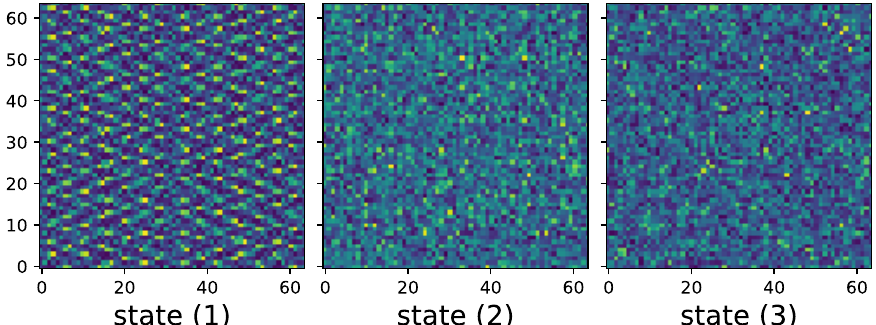
) | under a bipartitioning Figure 2: (Color Online) Color map of the matrix | Ψ ( x , x A B of the system for (1) a state evolved with a Clifford circuit; (2) a state evolved with = 12 T gates inserted; (3) a random the composite quantum circuit in Fig. 1 with n T state with entries drawn from a Gaussian distribution. Blue (darker) corresponds to ) | and yellow (lighter) corresponds to larger values. The smaller values of | Ψ ( x , x A B system size is N =